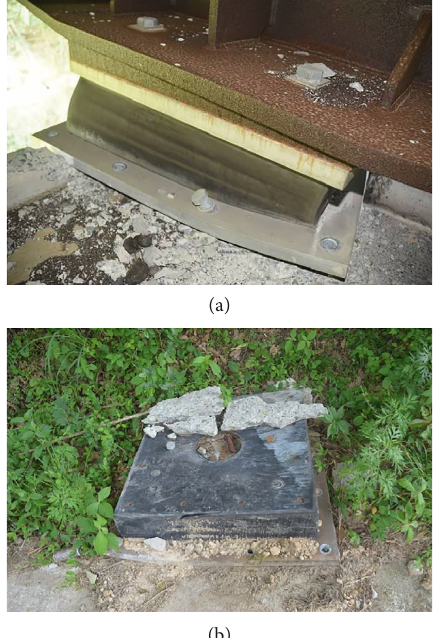
Figure 18: (a) Deformed rubber bearing under girder 1 at pier 2.